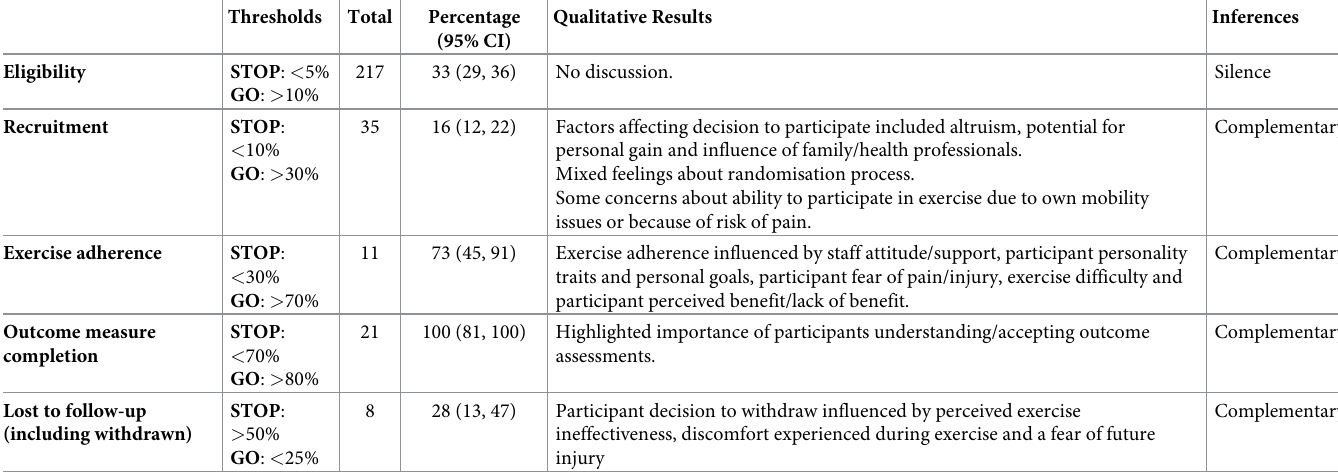
Table 5. Progression criteria: Joint display of quantitative and qualitative